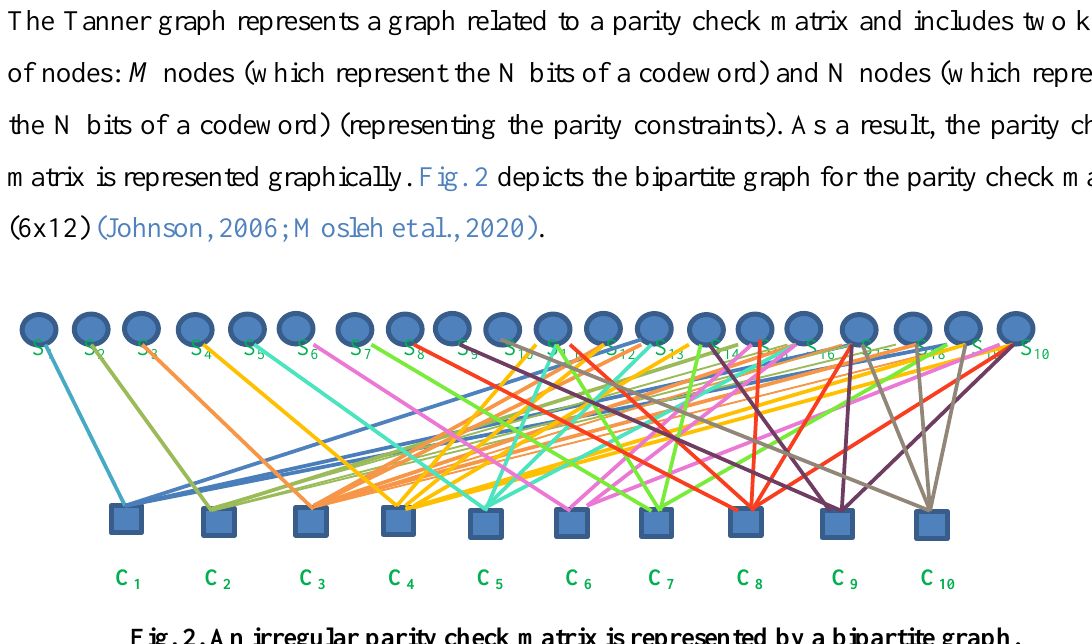
Fig. 2. An irregular parity check matrix is represented by a bipartite